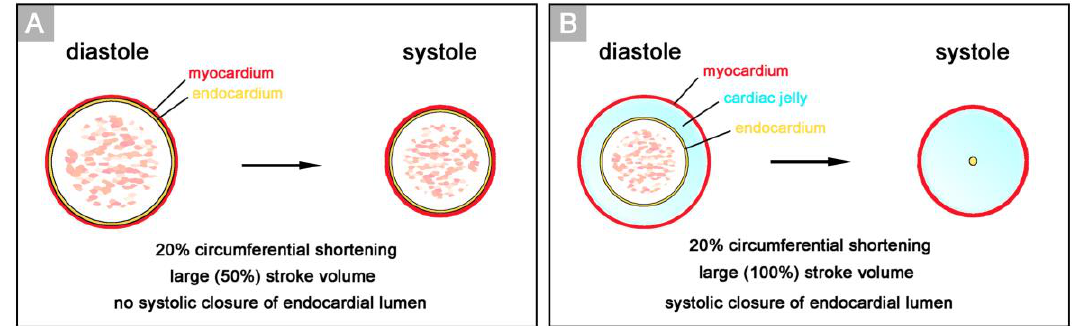
Figure 2. These schematic drawings illustrate Barry’s geometrical analyses on cross sections of hypothetical heart tubes of a large diameter. ( A ) In a hypothetical heart tube without CJ, physiological shortening of the contracting myocardium (20%) produces a large change (50%) in the cross sectional area of the lumen (= stroke volume), but does not close the lumen. ( B ) In a hypothetical heart tube with CJ, physiological shortening of the contracting myocardium will produce a large change (100%) in the stroke volume as well as complete closure of the endocardial lumen, if the thickness of the CJ layer is about 45% of the radius of the diastolic lumen. Note that the spatial distribution of CJ in the hypothetical heart tube does not correspond to the non-uniform distribution of CJ (bilaterally paired character) found in real embryonic heart tubes (see Figure 1A).